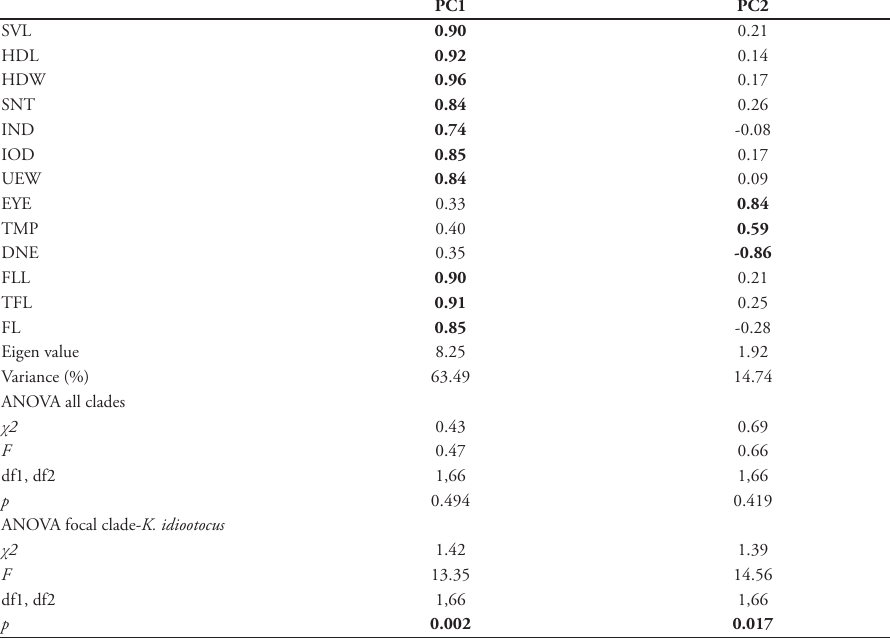
Table 3. Variables and results for the Principal Component Analysis and resulting ANOVA. Principal components were to be extracted if their eigenvalue > 1, under a varimax rotation. Variables were selected as loading into a PC if the value is > 0.58. In bold are variables retained as loading into one if the PCs. Based on the variables loading on to each of the PCs, we assigned PC1 to the general morphology and PC2 to the horizontal head structure. PC1 and PC2 were not significantly different between Kurixalus inexpectatus sp. nov. and other Kurixalus species under a one-way ANOVA, but they were significantly different between Kurixalus inexpectatus sp. nov. and K. idiootocus . The sample sizes used in the analysis were such as: K. inexpectatus sp. nov. n = 12, K. idiootocus n = 8; all n = 71; details in the Suppl. material 2). PC1 PC2